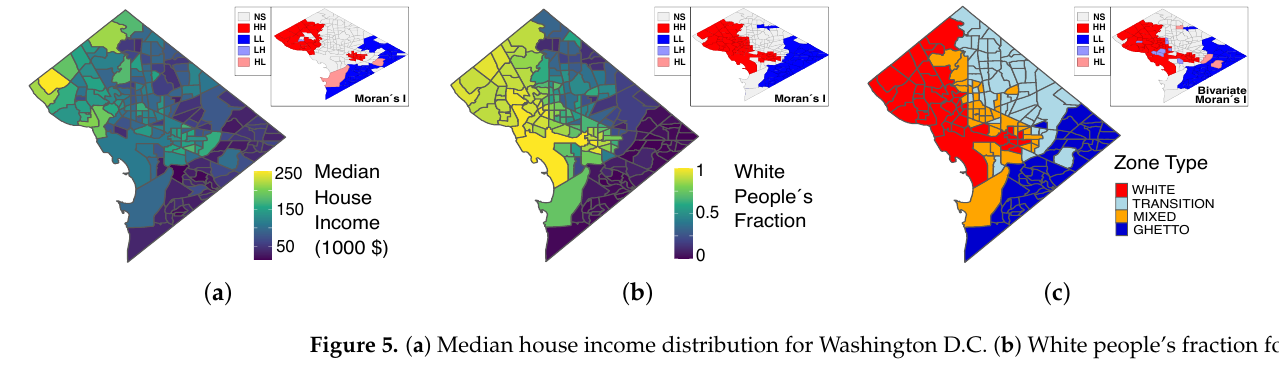
Figure 5. ( a ) Median house income distribution for Washington D.C. ( b ) White people’s fraction for our region of interest. ( c ) Zone types found by the EM clusterization algorithm. The insets in ( a ) and ( b ) represent the local Moran’s I. The inset from ( c ) illustrates the local Moran’s bivariate index choosing as variables the median house income and the white people’s fraction. In these insets, NS means Not Significant, while H and L denote High and Low values, respectively. Spatial Analysis software Geoda was used for the insets